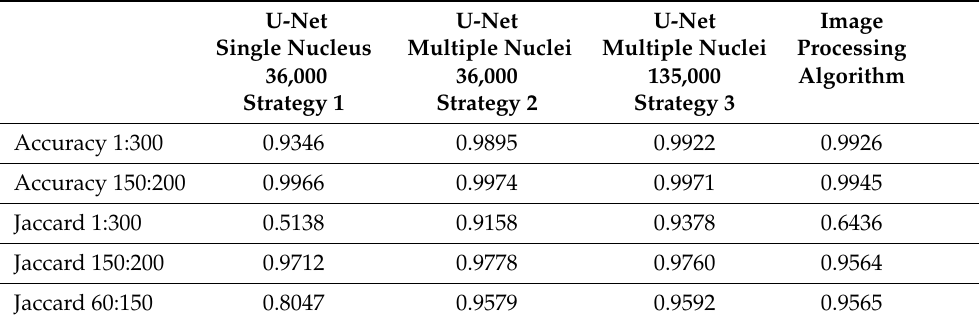
Table 1. Numerical results of the accuracy and Jaccard similarity index obtained in one cell for which ground truth was available. It is important to highlight that “single nucleus” and “multiple nuclei” refer to the evaluation, not the training. U-Net U-Net U-Net Image Single Nucleus Multiple Nuclei Multiple Nuclei Processing 36,000 36,000 135,000 Algorithm Strategy 1 Strategy 2 Strategy